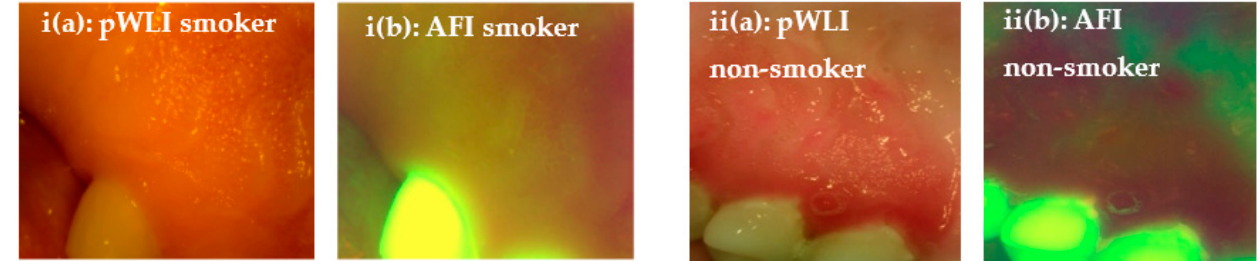
Figure 5. Papillary hyperplasia in ( i ) smoker (left image pair), ( ii ) non-smoker (right image pair). Left side of each image pair ( a ): polarized white light image; right side of each image pair ( b ): autofluorescence image. In the polarized white light image of the smoker’s tissues (left image pair, left side ( i ( a )), note the thick, dry, red, fibrosed surface layer in the smoker’s tissues which shows considerably more backscattering in the autofluorescence image (left image pair, right side ( i ( b )) vs. the non-smoker’s tissues (right image pair ( ii ( a ) and ii ( b )). Table 3 summarizes the comparison of the screening algorithm performance vs. the oral medicine specialist. The algorithm achieved 80.0% sensitivity, 86.4% specificity, and 83.3% agreement with the specialist screening outcome in tobacco smokers, and 62.2% sensitivity, 83.5% specificity, and 73.3% agreement with the specialist screening outcome in non-smokers. For comparison purposes, we also evaluated the algorithm screening outcomes for all subjects combined, achieving an overall sensitivity of 71.0%, a specificity of 75.4%, and an agreement of 73.2% with the oral medicine specialist screening outcome for the two groups